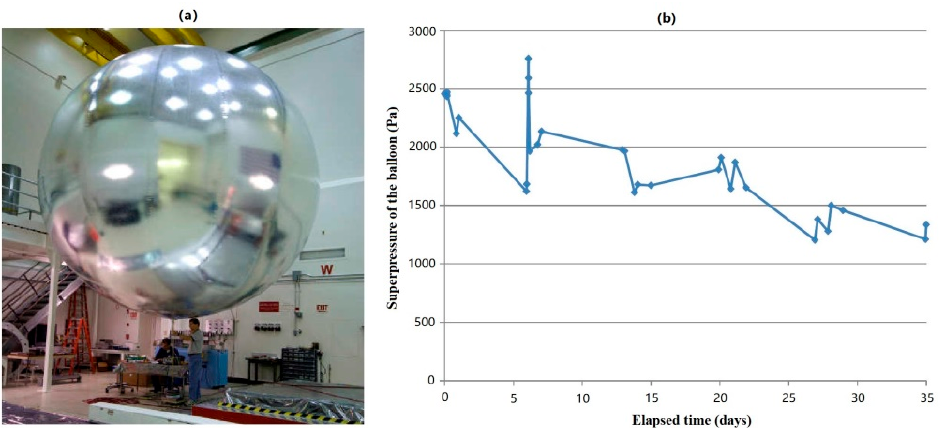
Figure 1. ( a ) A 5.5 m diameter prototype balloon undergoing testing; ( b ) 35-day buoyancy test data [9].